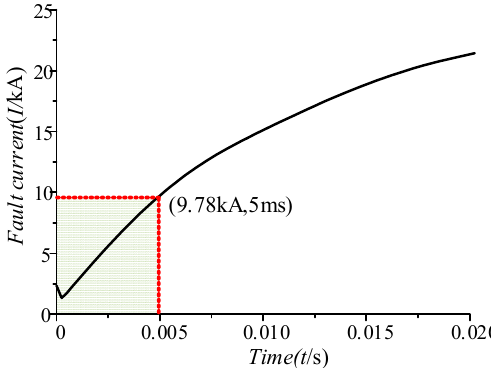
Figure 8. Fault current of DCB3 under Fault F3.